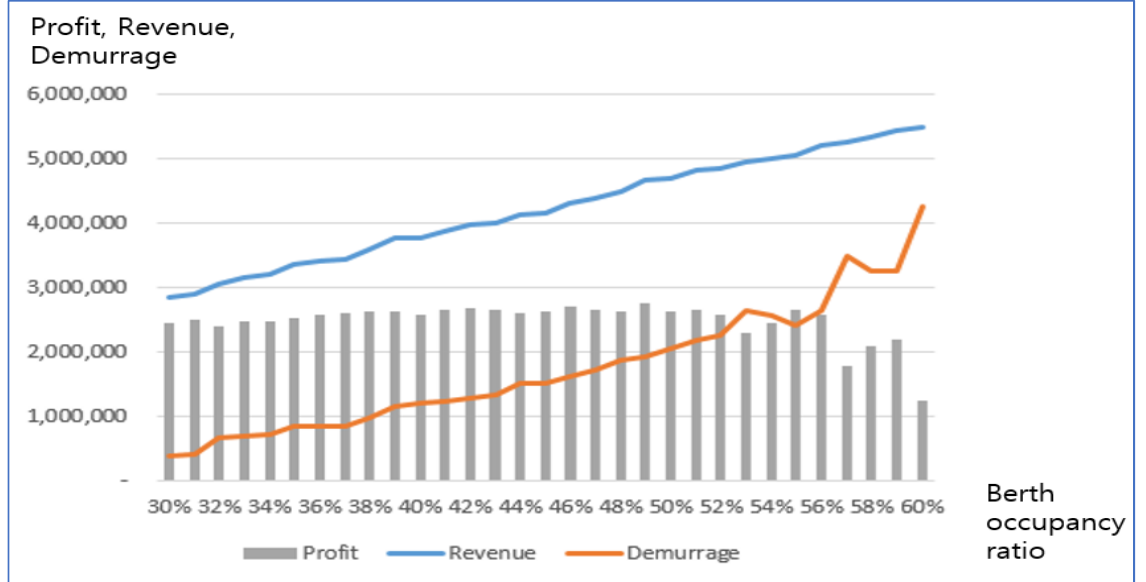
Figure 7. Dolphin profit and occupancy with USD 40,000 demurrage per day.